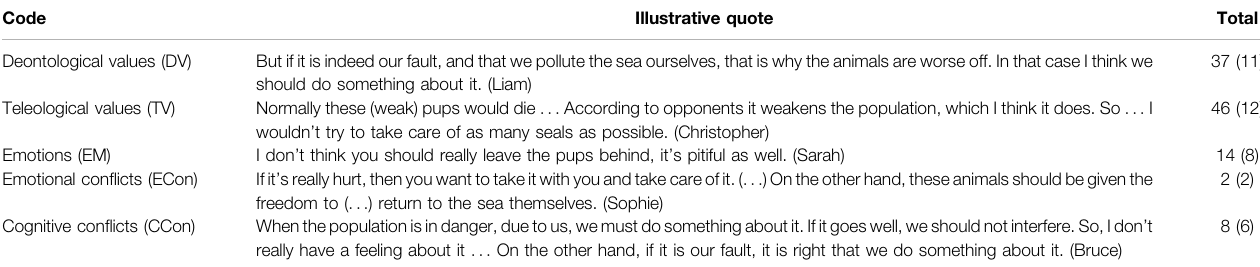
TABLE 7 | Students ’ morality regarding their moral motivation ( n (cid:1)